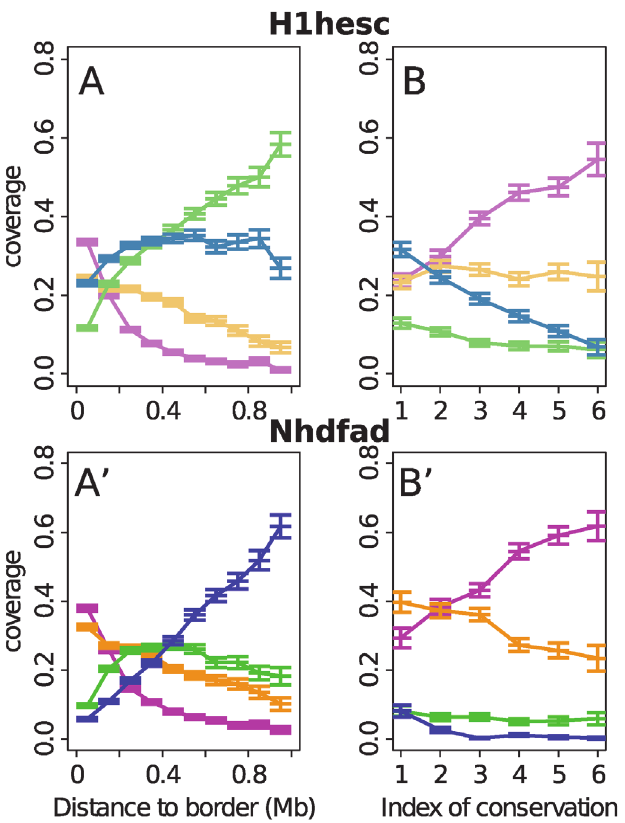
Figure 7. Distribution of chromatin states inside replication timing U-domains of H1hesc and Nhdfad. (A) Mean coverage of chromatin states with respect to the distance to the closest U-domain border in the H1hesc cell line. (B) Mean coverage of ESC chromatin state in the 100kb window containing a U-domain border with respect to the conservation index n of the U-domain border (Materials and Methods). (A ’ , B ’ ) same as (A, B) for the Nhdfad cell line. Same color coding as in Fig.